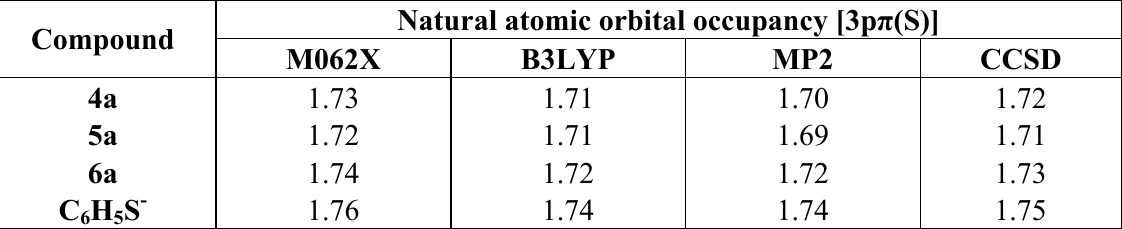
Table 8. The natural atomic orbital occupancy of the 3p  atomic orbital of the sulfur atom of silaphenylthiolates 4a – 6a and the parent all-carbon phenylthiolate a .